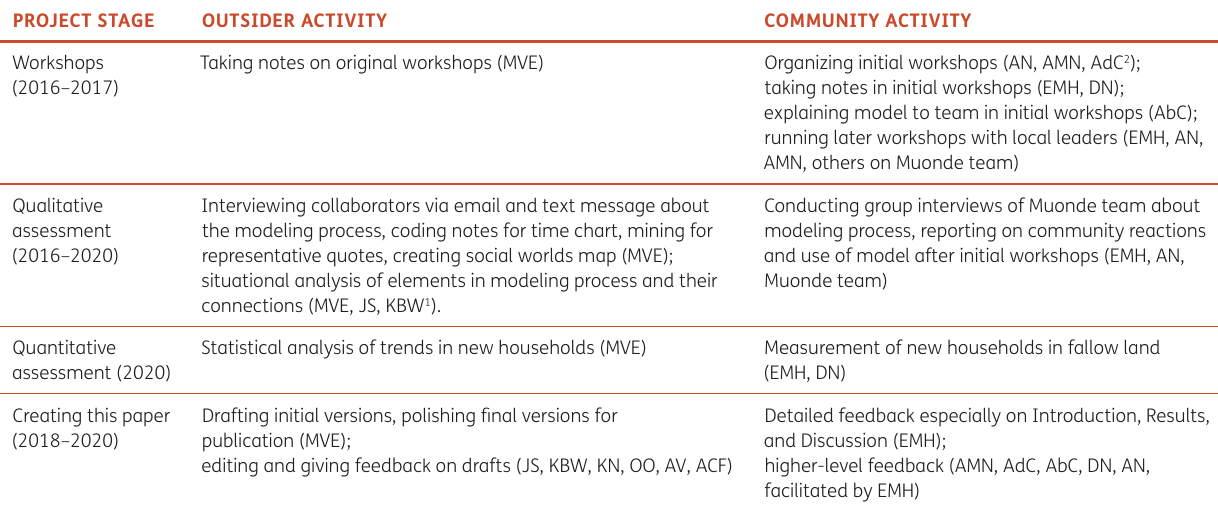
Table 2 Modeling assessment processes; authors’ involvement is indicated by their initials (see Supplemental File 1: Appendix A and Supplemental File 2: Appendix B for a detailed accounting of activities and participants in each